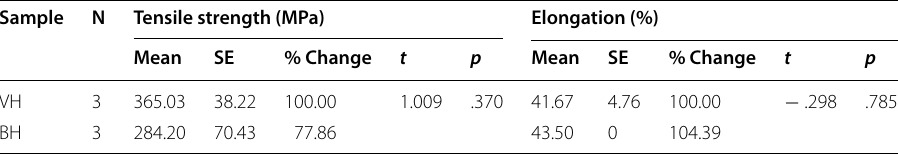
Table 4 Tensile strength and elongation of virgin hair (VH) and bleached hair (BH) and the results of t